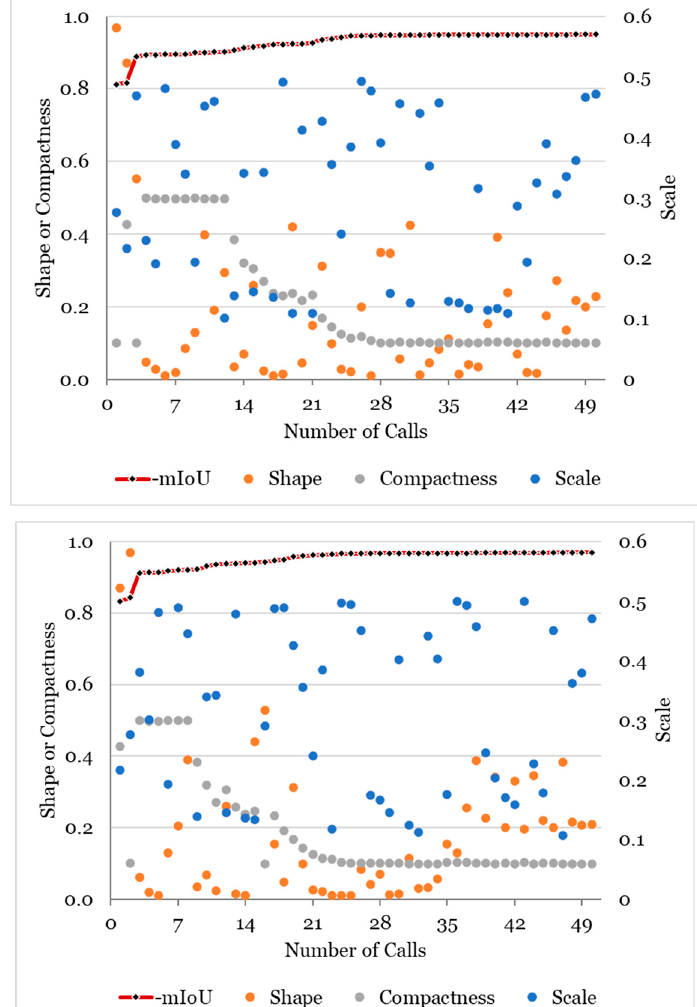
Figure 12. Sensitivity analysis on MRS segmentation parameters.